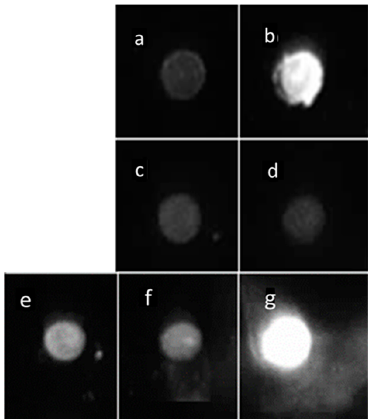
Figure 6. Dot blot of immunoprecipitation (IP) pull-down using B3-9 c-mAb: IP of cell fraction obtained after centrifugation and revealed with the polyclonal anti-Bcl-xL antibody: ( a , c ) fraction obtained from SH-SY5Y control and ( b , d ) SH-SY5Y stressed for 24 h with FeCl 3 ; ( a , b ) resulted from IP pull-down; ( c , d ) resulted from the flow-through of the IP and constituted the negative control. ( e – g ) constituted the positive controls with blotting for ( e ) BclxLcl37, ( f ) BclxLnf70, and ( g ) BclxL- Δ TM monomer.